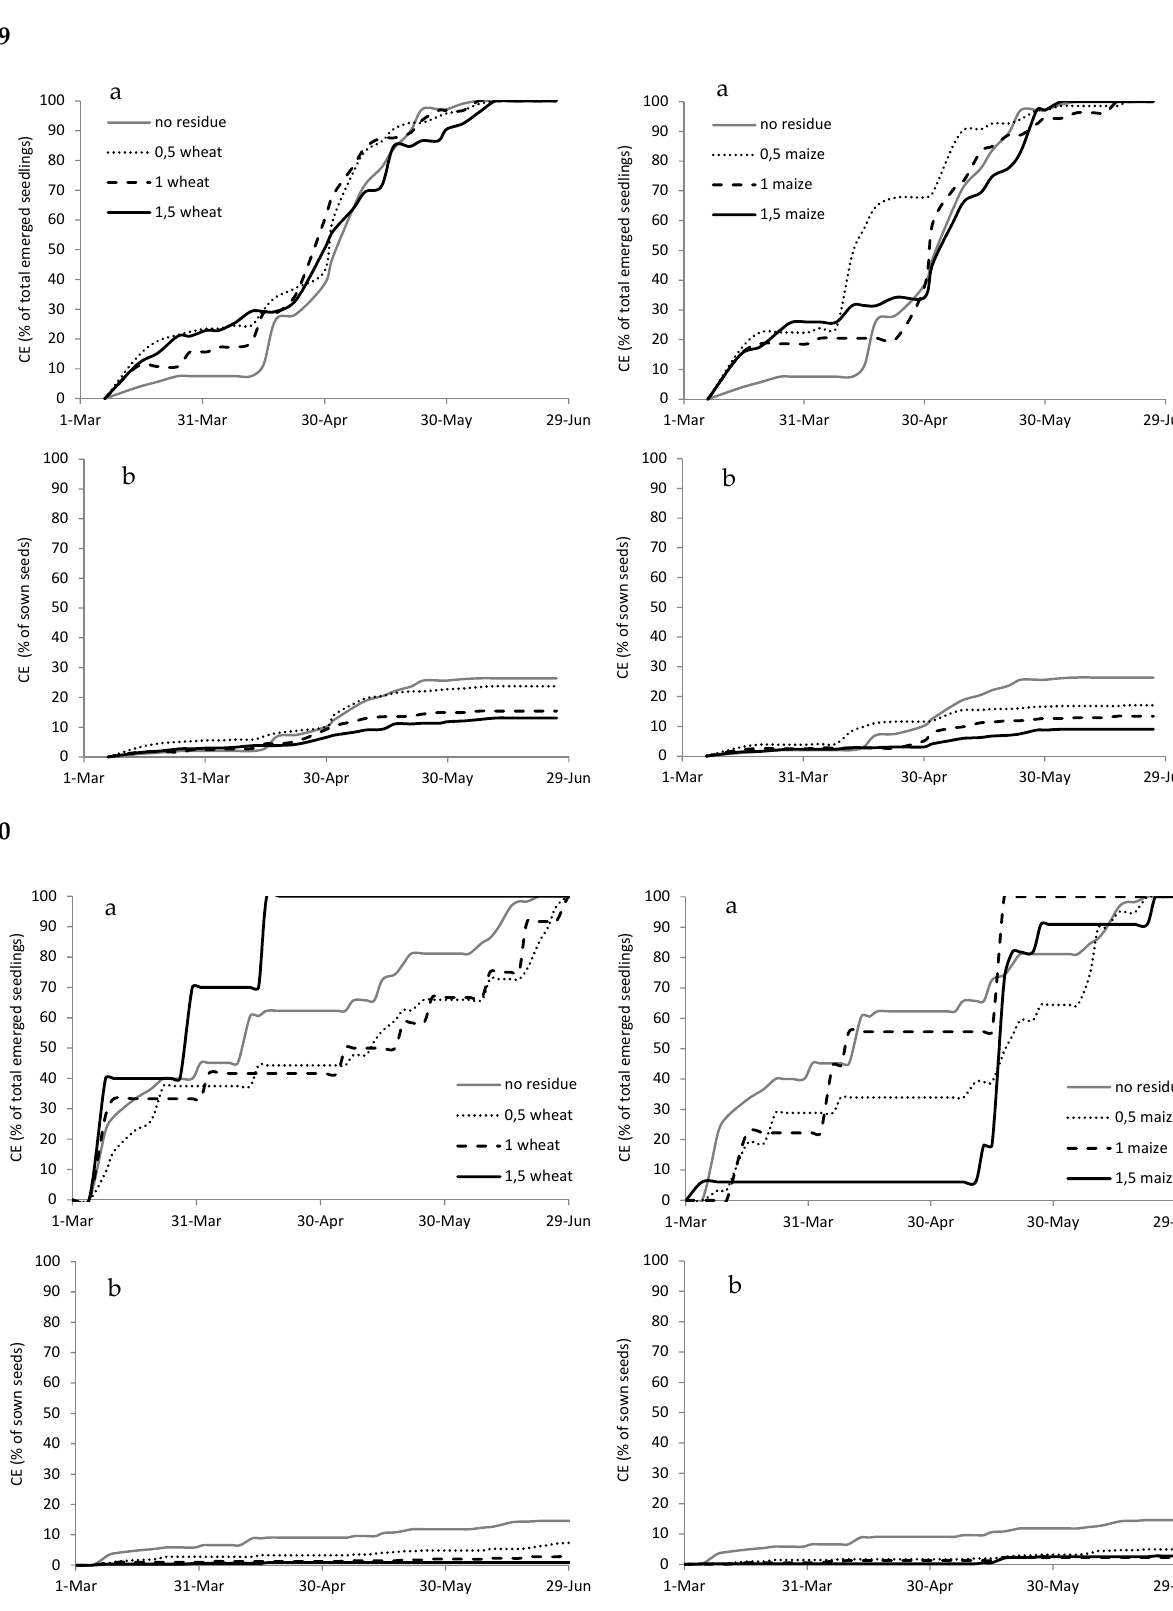
Figure A2. Cumulated emergence (CE) expressed as percentage of total emerged seedlings ( a ) and as percentage of sown seeds ( b ) of Amaranthus retroflexus in 2019 and 2020 with different types (wheat on the left and maize on the right) and amounts of crop residues.